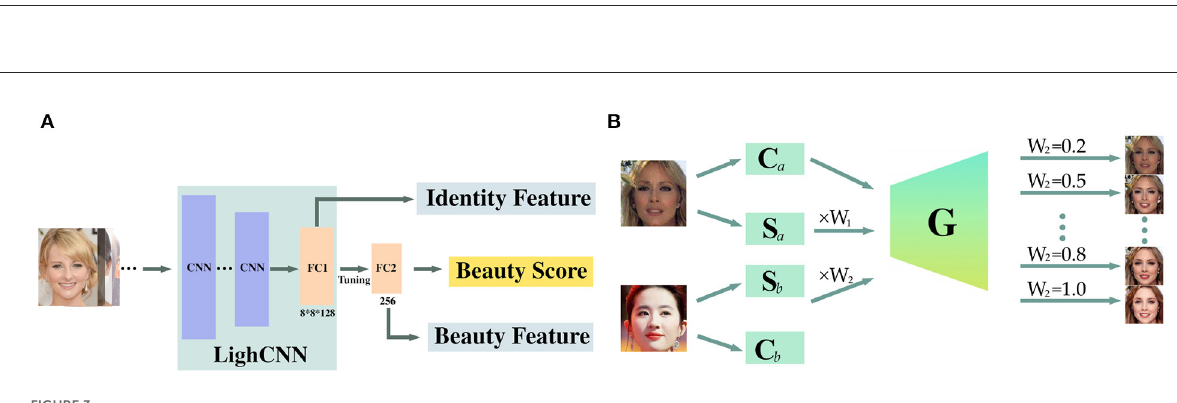
FIGURE3 (A) Fine-tuning network for beauty score prediction. (B) Testing stage for fine-granularity beautification